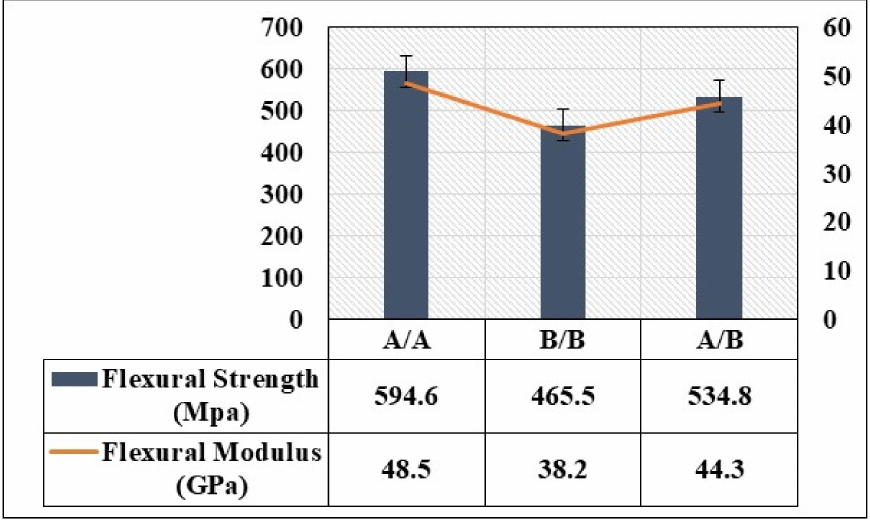
Figure 5. Flexural strength and flexural modulus of the composite